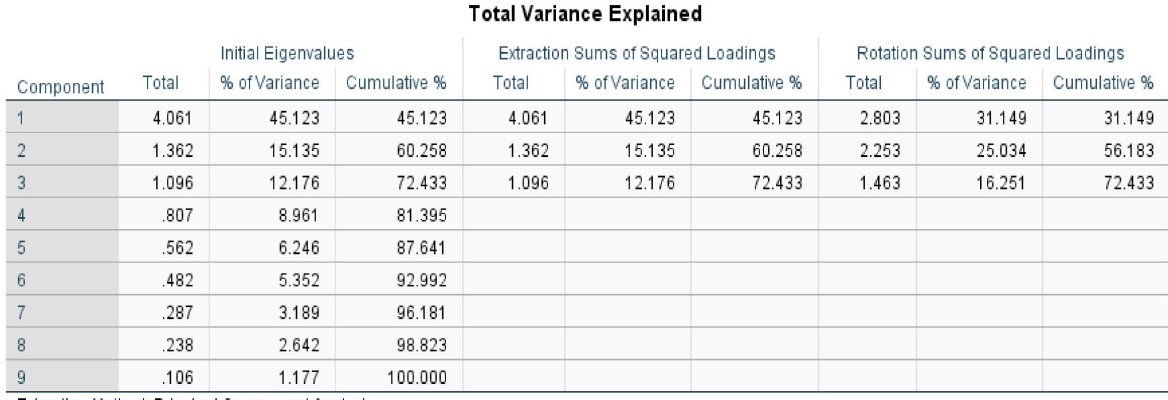
Table 5. Total Variance Explained (output from